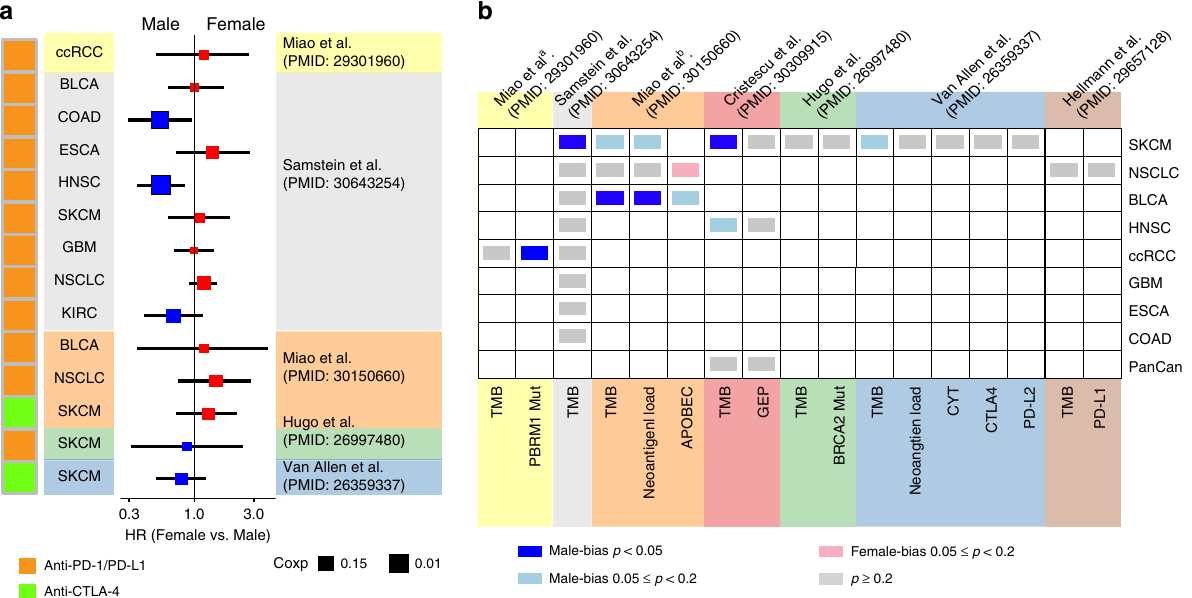
checkpoints (e.g., BTLA and CD80) and immune cell populations (e.g., activated CD4 + /CD8 + T cell) and validated this pattern in one independent data set (GSE47115) 32 (Supplementary Fig. 7b).